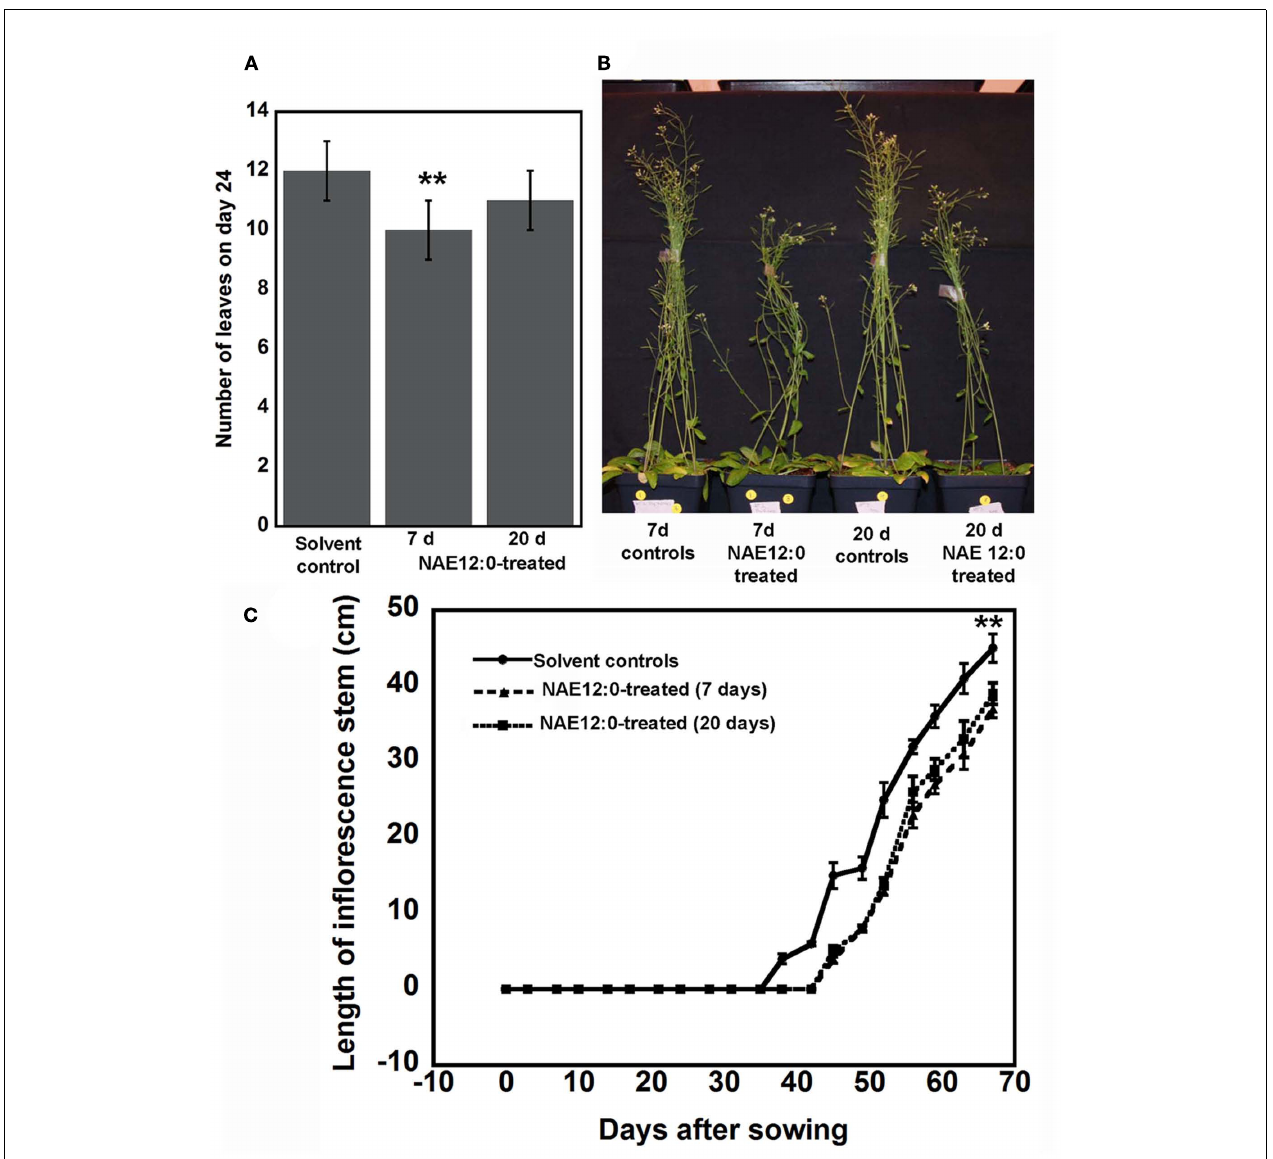
inflorescence stems of NAE 12:0-treated plants. (C) Quantification of the length of the inflorescence stem after the initiation of flowering. Note that flowering in NAE 12:0-treated plants was delayed by about 6days regardless of whether the plant was treated at 7 or 20days after planting. Asterisks indicate statistically significant difference according to Student’s t -test ( p <